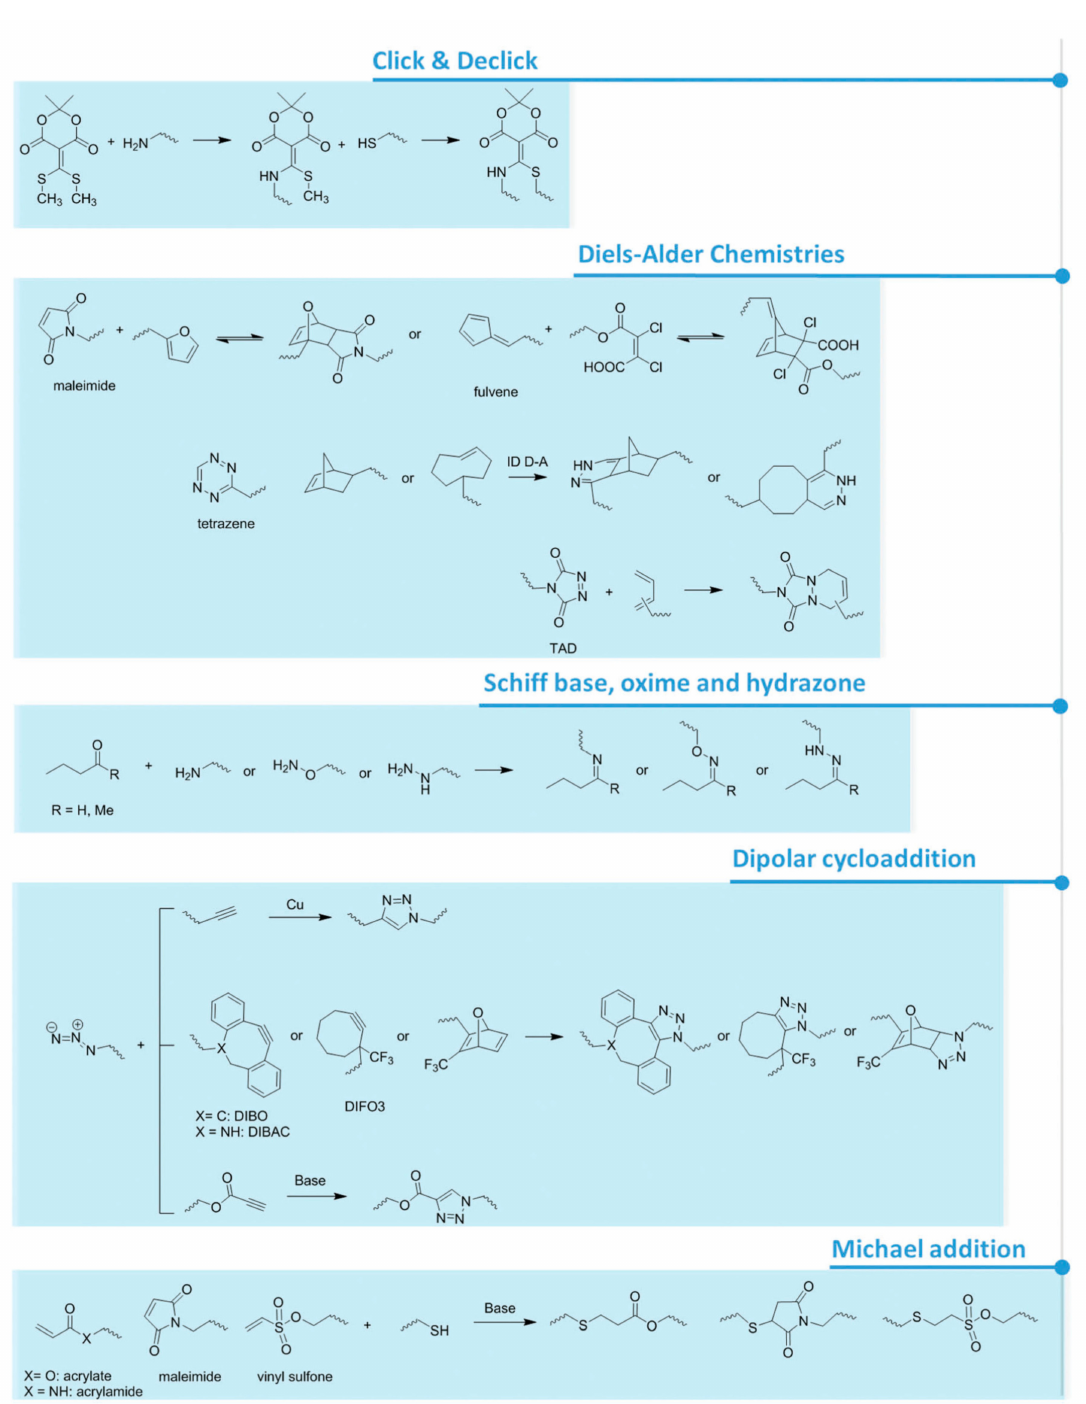
Figure 3. Schematics presenting several functional groups involved in hydrogel formation [128] and attachment of biomolecules via covalent